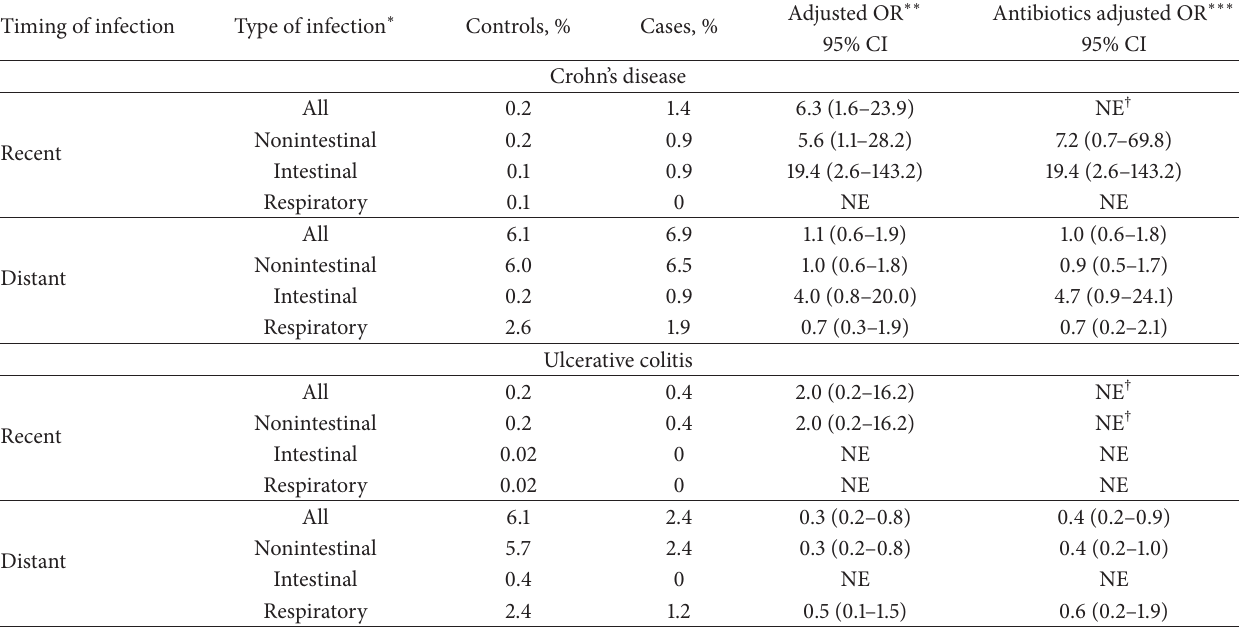
Table 2: Adjusted odds ratio and 95% confidence intervals for the association of hospitalized infections with risk of Crohn’s disease and ulcerative colitis by timing and type of infection.